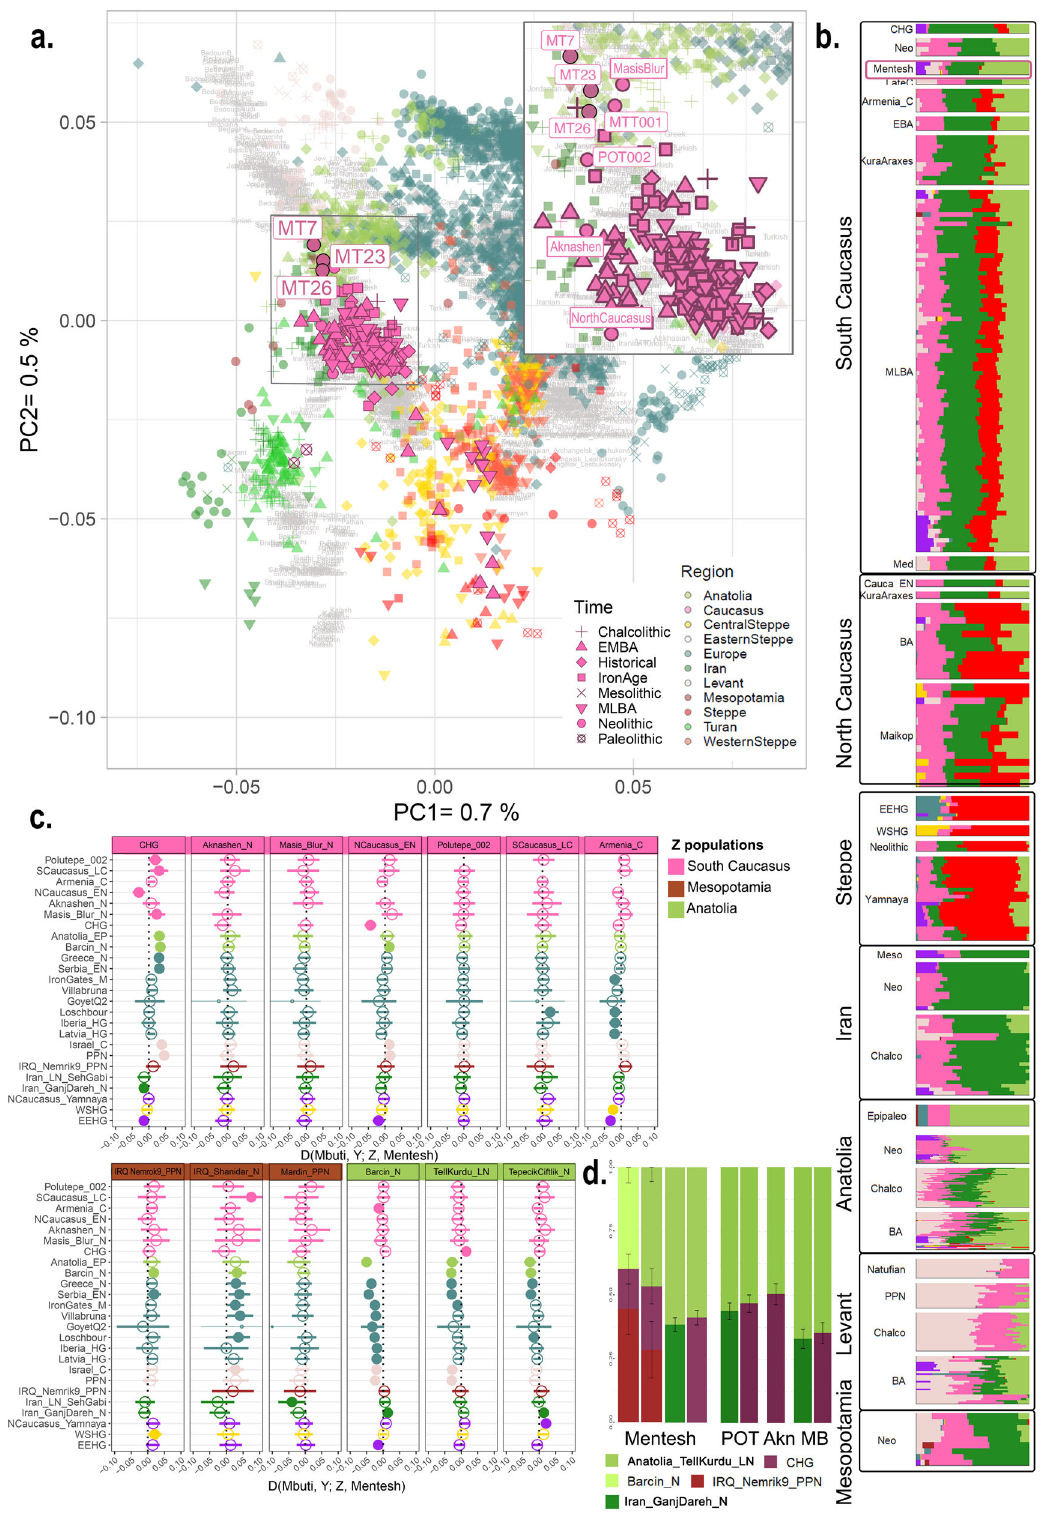
Fig. 2 Genetic af fi nities of the Mentesh Tepe individuals. a Principal Component Analysis calculated on 1390 published present-day individuals (in grey) with ancient individuals projected onto it. The new Mentesh Tepe samples are indicated by fi lled dark pink circles and are labelled. Zoom panel allows to label all the CaucasusNeolithicindividuals. b UnsupervisedADMIXTURE analysis,K = 9 for a selection ofancient populations. The Mentesh Tepeindividuals appear like other Neolithic and Chalcolithic individuals from the South Caucasus (lowlands_N and LateC). CHG, Caucasus Hunter-Gatherer; Meso, Mesolithic; Levant_EP, Levant Epipaleolithic; C or Chalco, Chalcolithic; EN, Early Neolithic; Neo, Neolithic; BA, Bronze Age. c D-statistics D(Mbuti, Y; Z, Mentesh Tepe). D-statistics tests whether either Z (or Mentesh Tepe) has excess af fi nity with Y and becomes negative (or positive). Values that deviate from 0 by the ±2 Standard Error (SE) — displayed by the error bars — are represented with a fi lled circle. d Ancestry proportions of the Neolithic group on autosomes calculated with qpAdm. Ancestry proportions are plotted with error bars representing ±1 SE. POT = Polutepe, MB = Masis Blur, Akn = Aknashen. COMMUNICATIONS BIOLOGY| (2023) 6:319